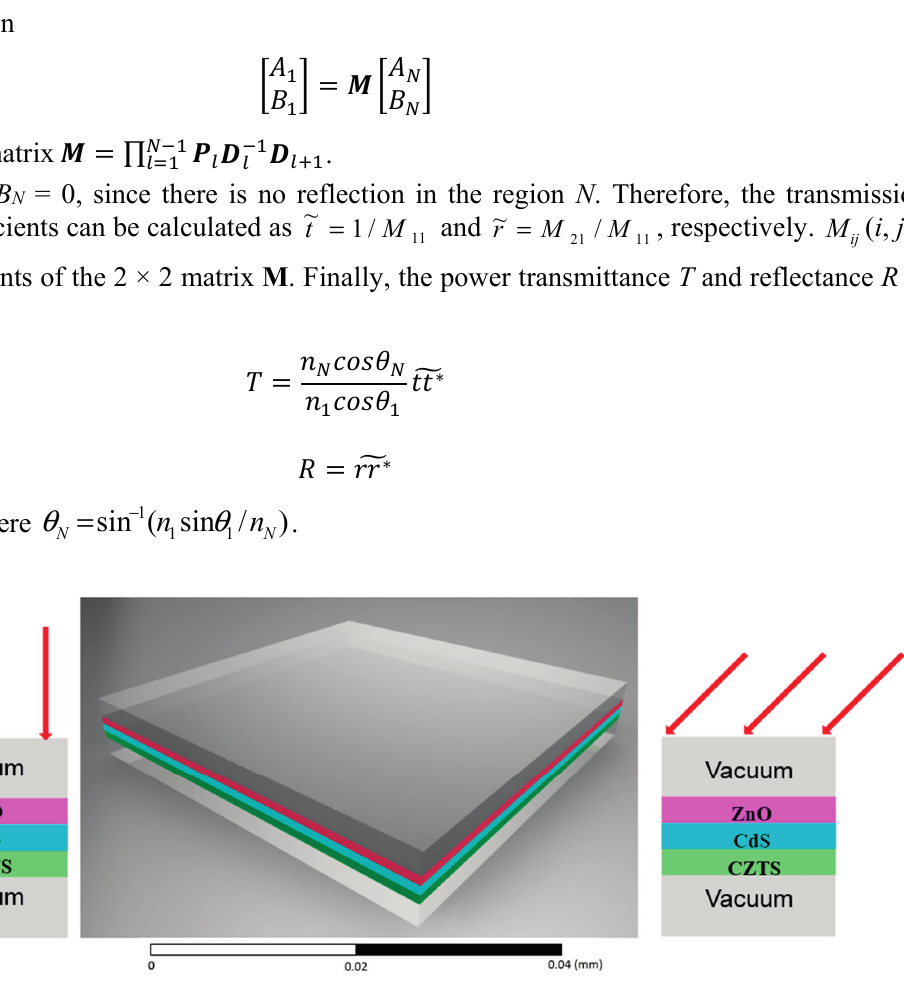
Figire 2. Five-layer thin film solar cell under different angles of